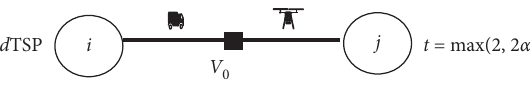
Figure 2: Best case for truck-drone (Agatz et al.,